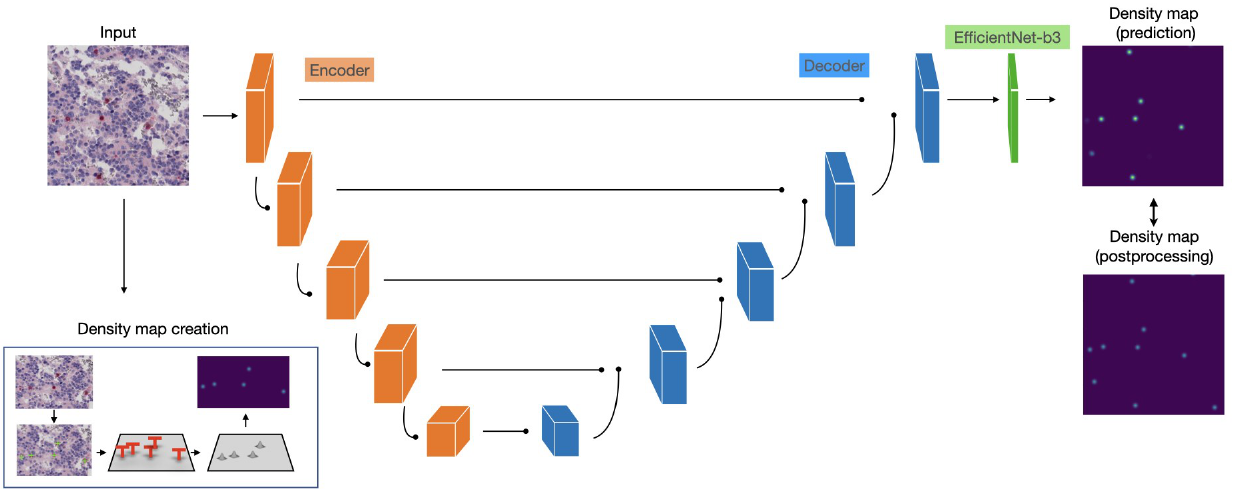
Figure 22. The full EUNet analysis